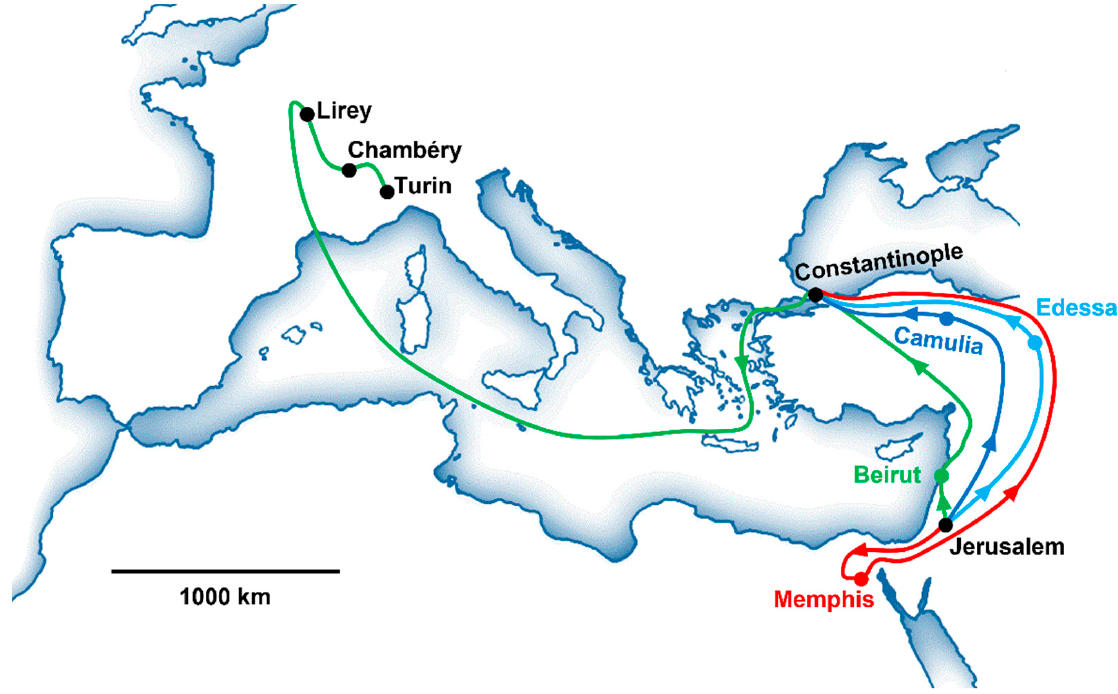
Figure 1. Alleged historical–geographical paths of the Shroud and its sojourns. From Constantinople to Lirey–Chambéry–Turin the four paths are identical and are shown all in green. From Jerusalem to Constantinople the four paths are different and have been schematized with different colors (see Table 1 for chronological details).